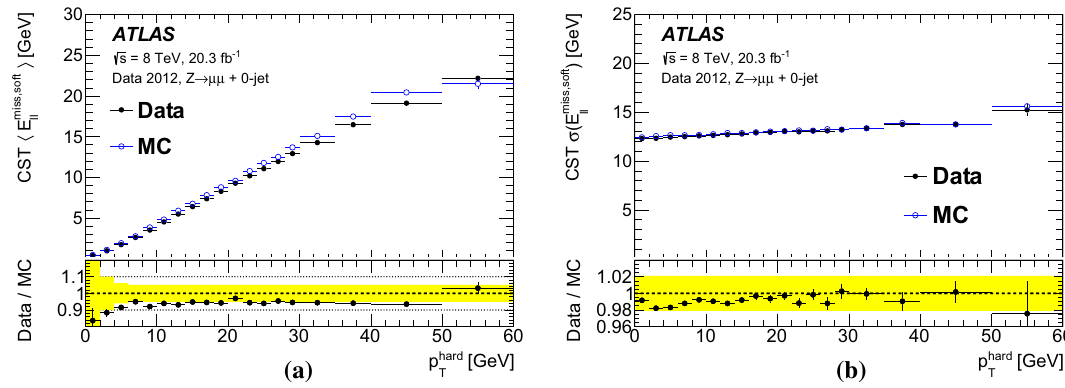
Fig. 20 The a mean and b Gaussian width of the CST (cid:3) E miss The ratio of data to MC simulation is shown in the lower portion of the plot with the band representing the assigned systematic uncertainty